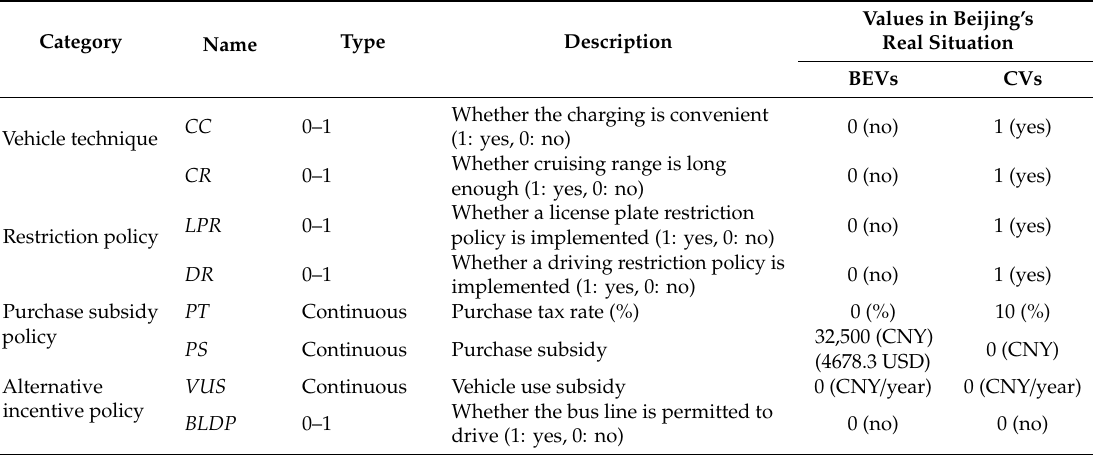
Table 1. Description of scenario variables. BEVs = battery electric vehicles, CVs = conventional vehicles, CC = charging convenience, CR = cruising range, LPR = license plate restrictions, DR = driving restrictions, PT = purchase tax, PS = purchase subsidy, VUS = vehicle use subsidy, and BLDP = bus line driving